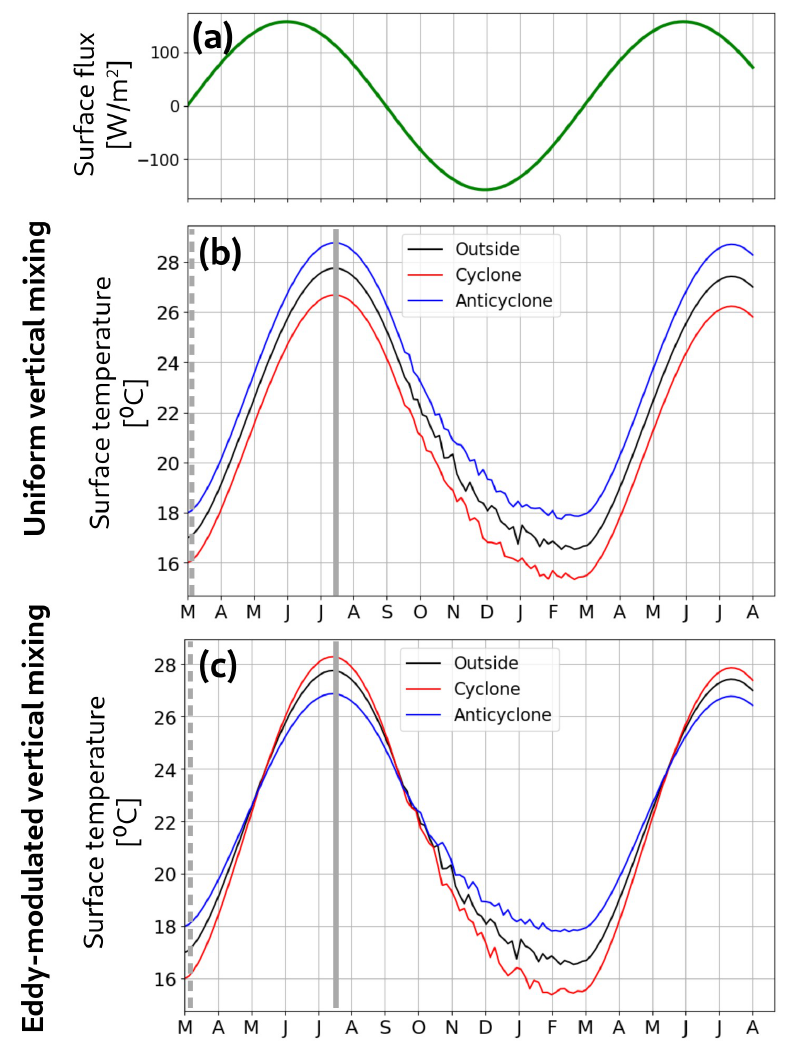
Figure 11. One-dimensional (1D) single column experiments: surface temperature. ( a ) Surface heat flux forcing the simulation, ( b ) Surface temperature evolution for anticyclone, cyclone and outside- eddy profiles with a uniform vertical mixing and ( c ) same as ( b ) but with an eddy-modulated vertical mixing, as shown in Figure